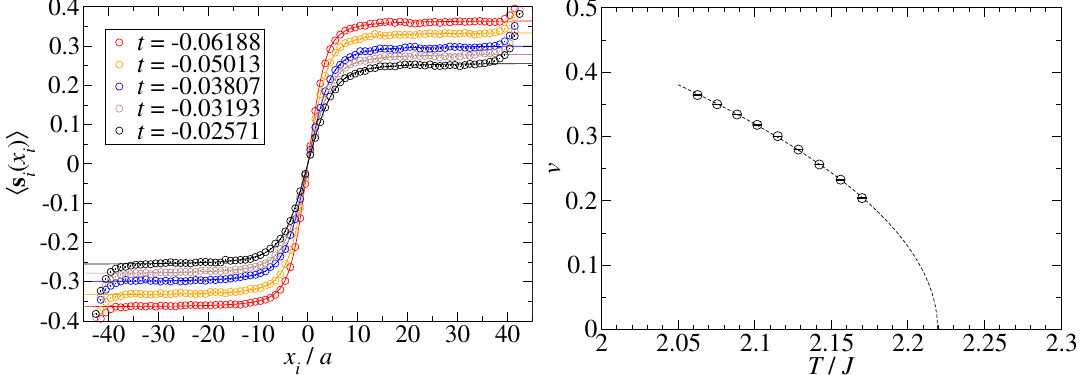
Figure 3 . Left-hand-side panel: profile of the i -th component of the spin along the main axes through the center of the lattice, as a function of the x i coordinate (in units of the lattice spacing), in the presence of boundary conditions enforcing a topological excitation in the low-temperature phase. The plot shows the results obtained from our Monte Carlo simulations on a lattice of spatial sizes L = 90 a and Euclidean-time extent R = 20 a , denoted as circles of different colors, for different values of the reduced temperature t , and their comparison with the theoretical expectation according to eq. (3.3), which was derived in ref. [5] from quantum-field-theory arguments. Right-hand-side panel: the average spin value v far from the defect core, obtained from fits to eq. (3.3), plotted against the temperature in units of the coupling, from different sets of simulations on lattices with L = 90 a and R = 20 a (including those displayed in the plot on the right-hand-side panel), and their fit to eq. (3.4).